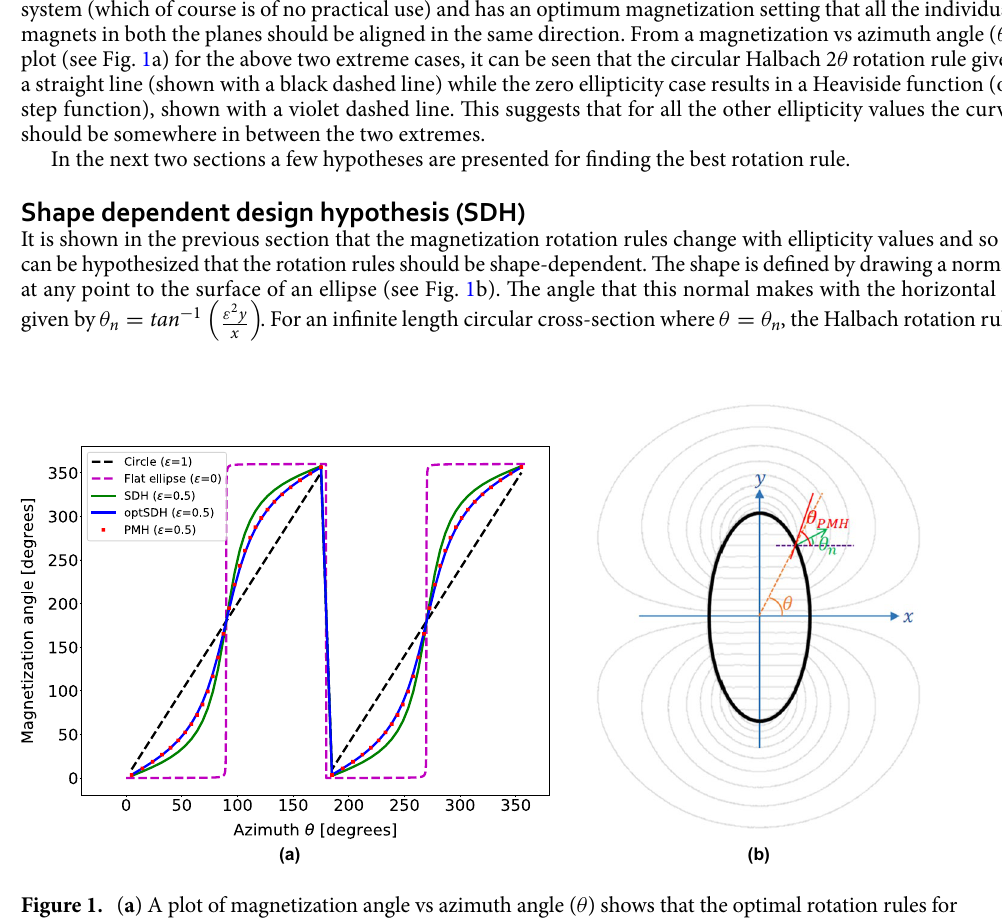
Figure 1. ( a ) A plot of magnetization angle vs azimuth angle ( θ ) shows that the optimal rotation rules for elliptic magnets are different from the Halbach case for a circular cross-section. The corresponding plots for a magnet with ellipticity 0.5 using a shape-dependent (SDH), optimized shape-dependent (optSDH) and the permanent-magnet hypothesis (PMH) are also shown. ( b ) A pictorial view to explain the three rotation rules. It shows that the Halbach rotation and SDH are geometric relations while PMH on the other hand suggests a connection to a virtual permanent magnet (VPM) as shown here. The magnetization in PMH follows the angle made by the magnetic flux lines emanating from the VPM’s surface i.e., θ PMH